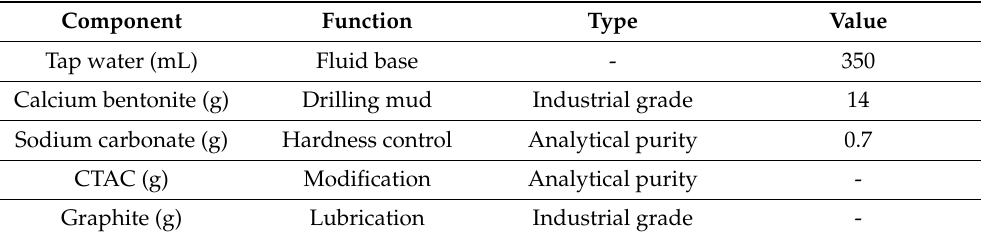
Table 1. Function of the modified graphite slurry.